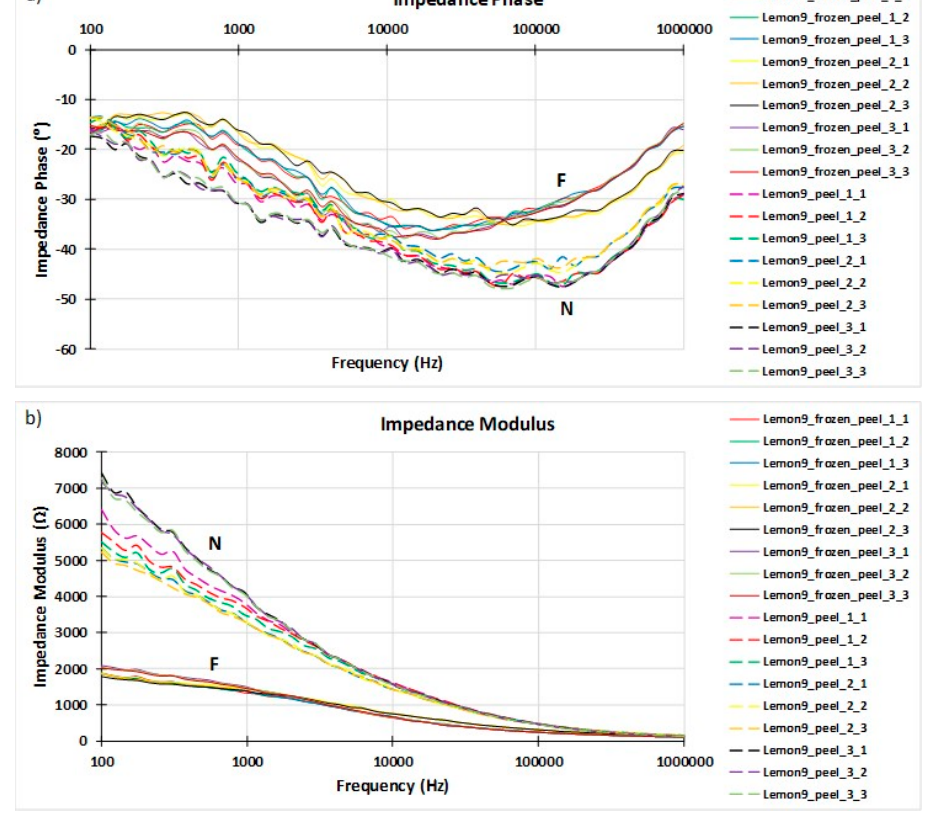
Figure 3. ( a ) Phase and ( b ) modulus of the EIS analyses for lemon number 9 both natural (N) and 12 h after freezing (F) using the sensor directly punctured on the peel.